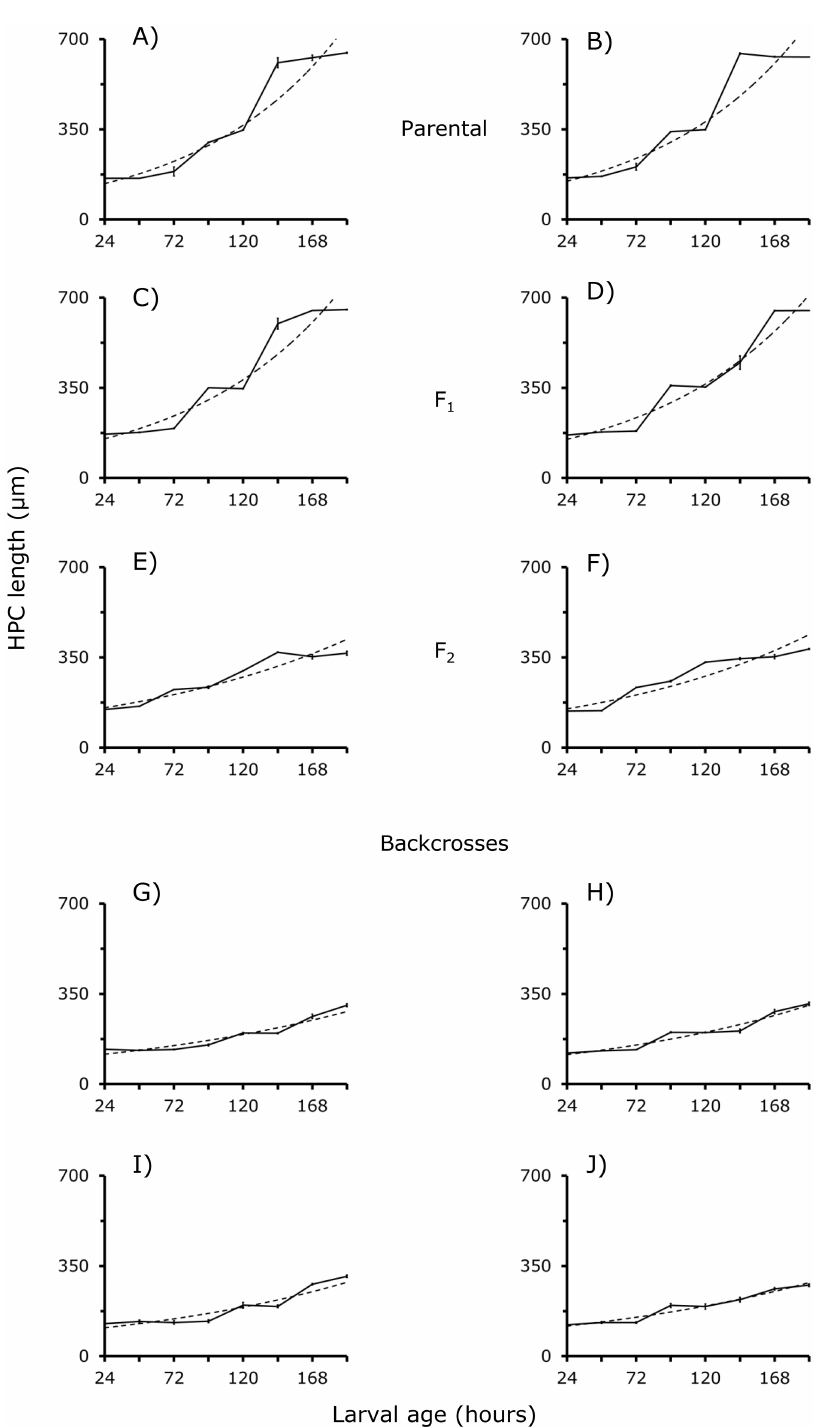
Fig 2. A–J. Growth in length ( μ m) of HPC in BA, A; CJ, B; F 1 , C and D; F 2 , E and F, and backcross larvae, G– J, of D . gaucha .For further detailssee Fig 4.